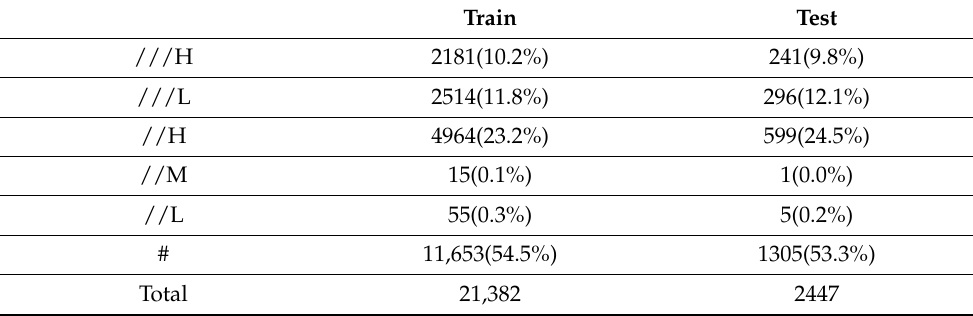
Table 10. Distribution of the five types of prosodic break in the experimental data.